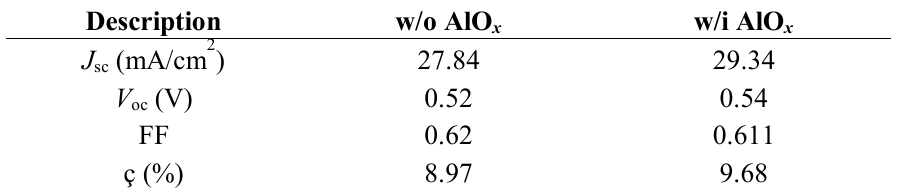
and with AlO homojunction solar cells. x x